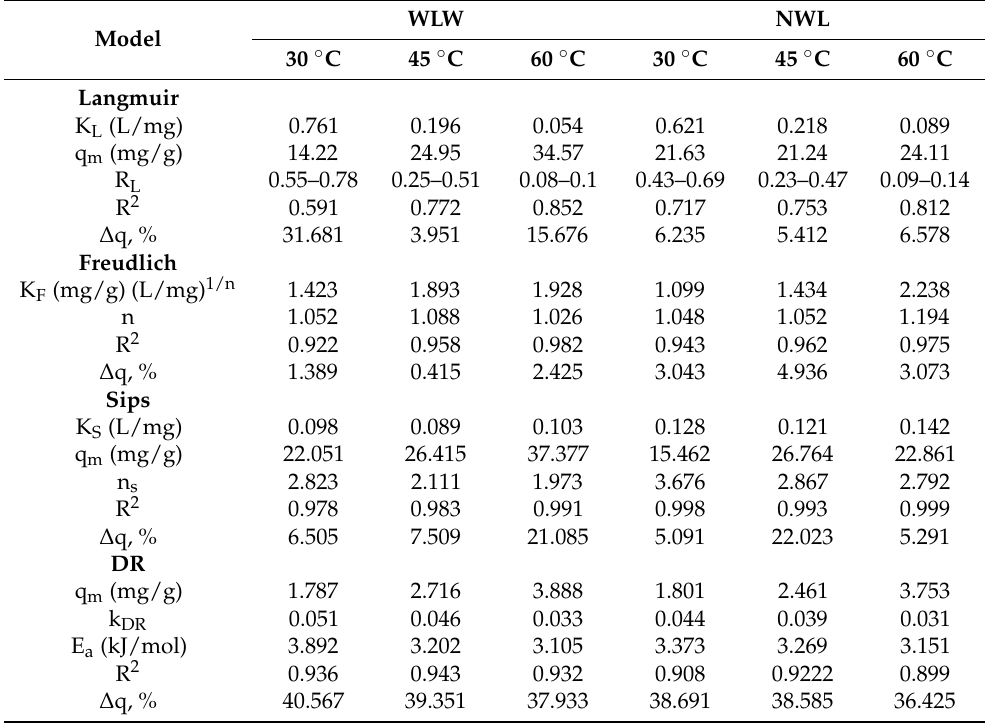
Table 2. Parameters for the isotherm models and PR adsorption with